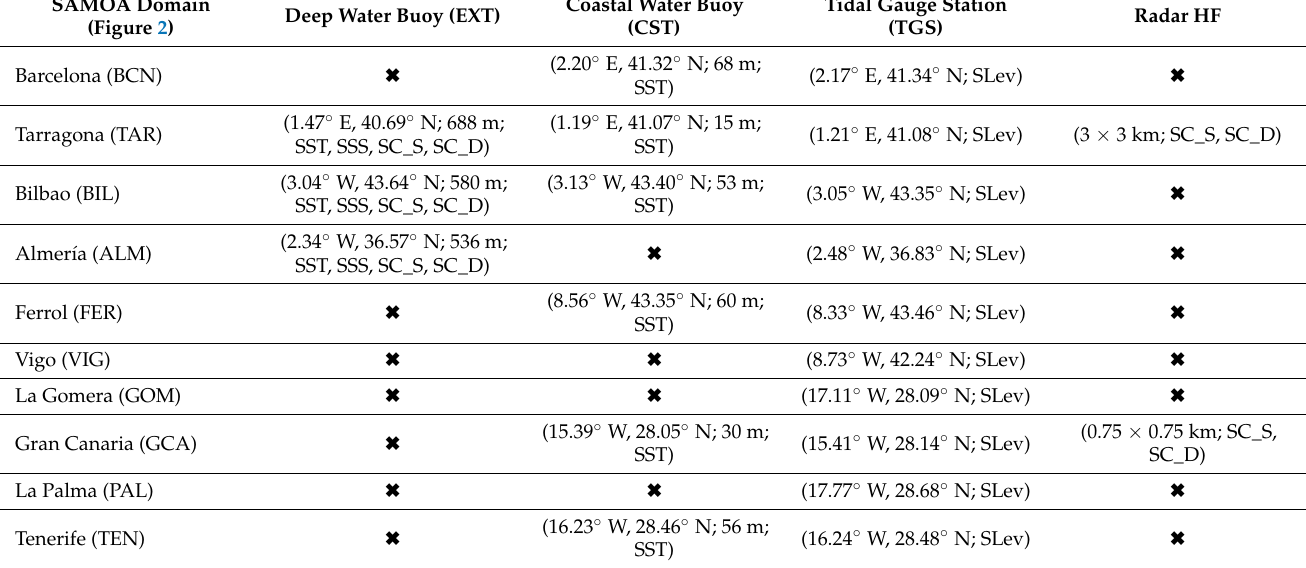
Table 2. Summary of the observational coverage available at each SAMOA domain. Rows denote the SAMOA domain, and the columns, the different elements of the PdE monitoring network (deep water buoys (EXT), coastal water buoys (CST), tidal gauge stations (TGS) and Radar HF) used in the model validation. The (cid:54) symbol means unavailability of a certain type of sensor in the area. If there exists a monitoring device within the SAMOA domain, its main features are summarized in brackets including: location (longitude, latitude), mooring depth (in m), spatial resolution (in km) for the HF Radars and measured variables (Sea Surface Temperature, SST; Sea Surface Salinity, SSS; Surface current speed, SC_S; Surface current direction, SC_D; Sea Level,